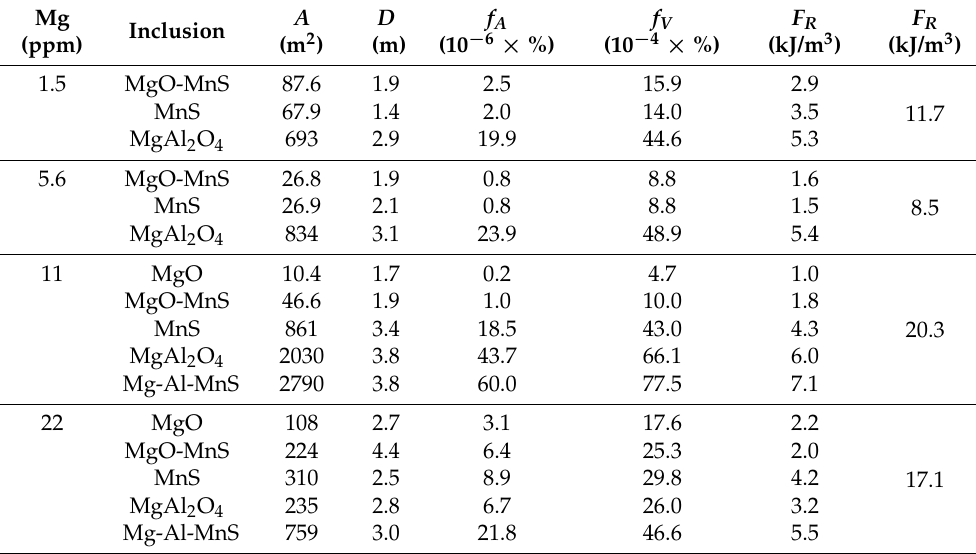
Table 5. The retarding force ( F R ) of